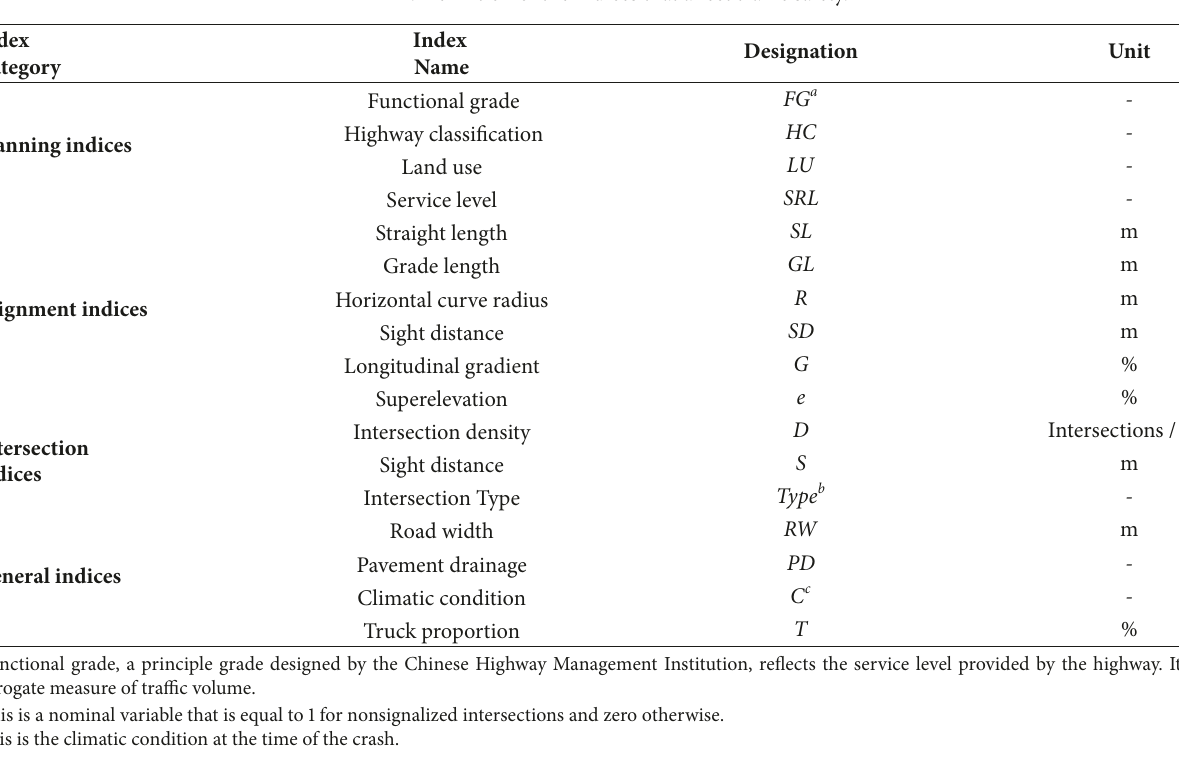
Table 2: Definition of the indices that affect traffic safety.